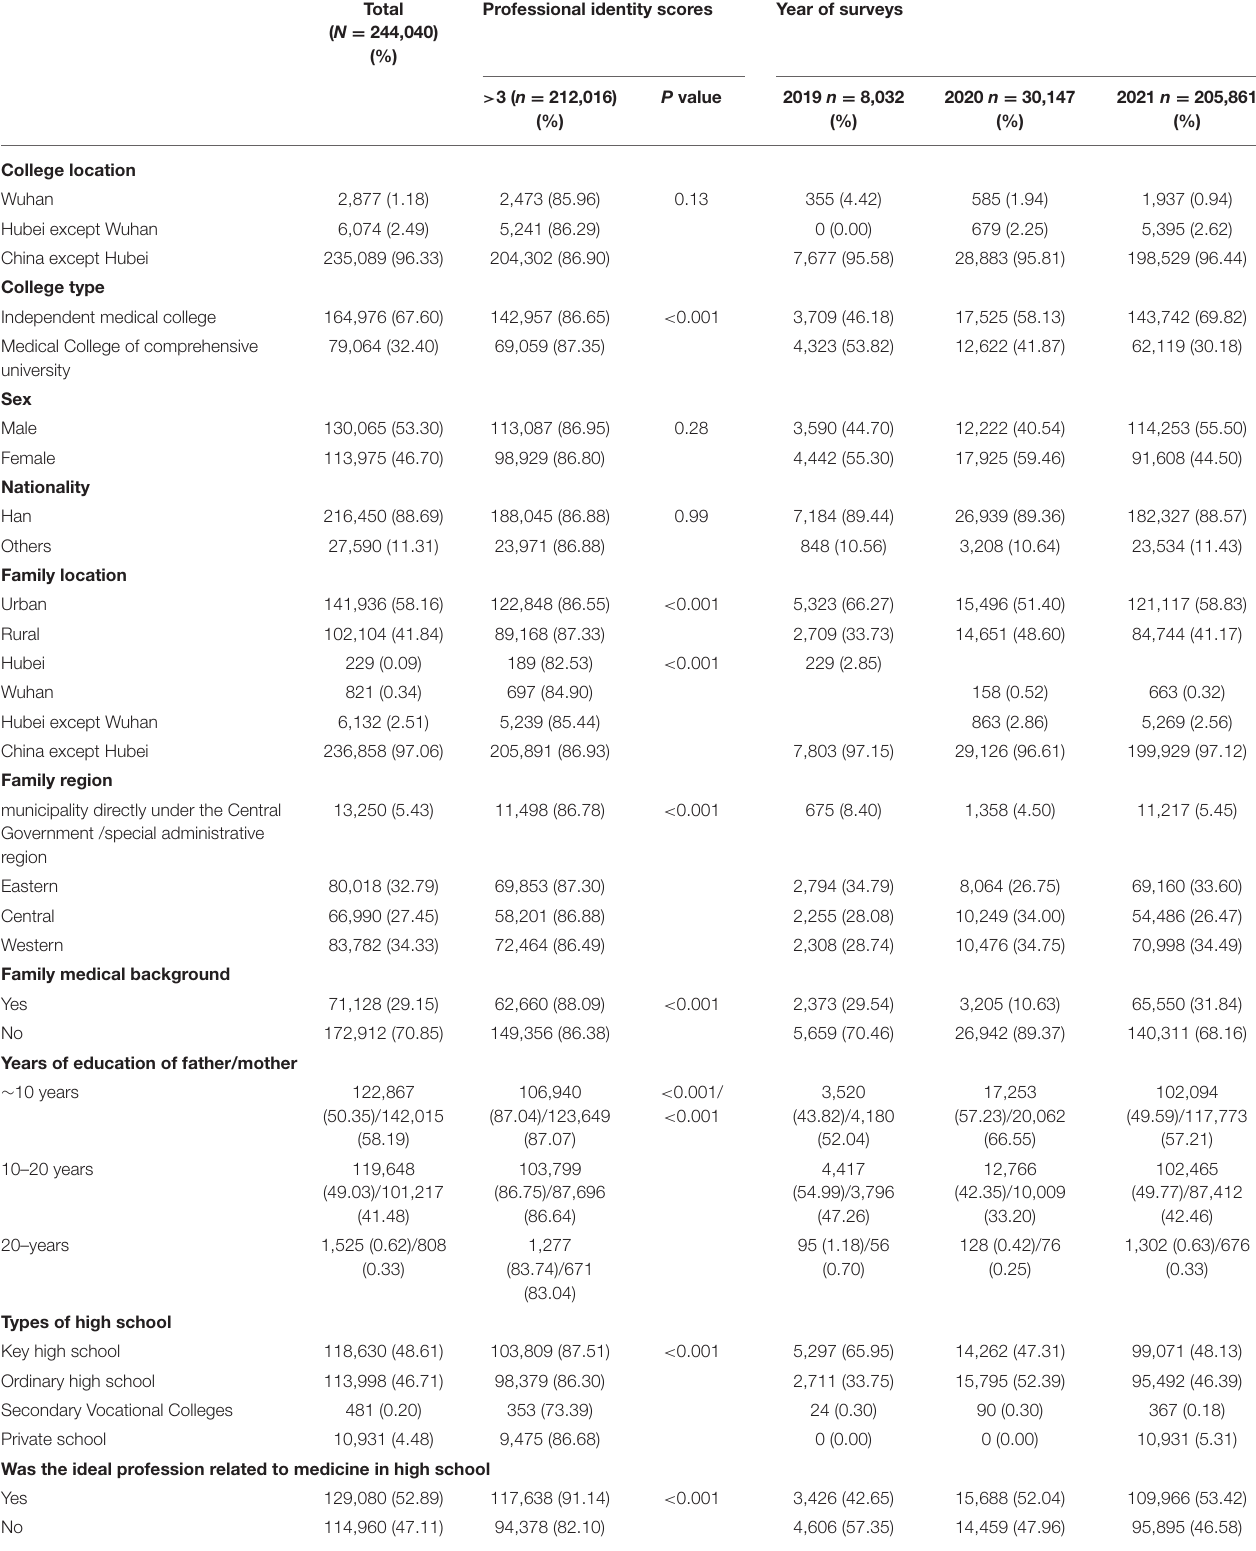
TABLE 2 | Rates of professional identity score over 3 in medical students in China by demographic characteristics, and characteristics of participants in the 2019, 2020, and 2021